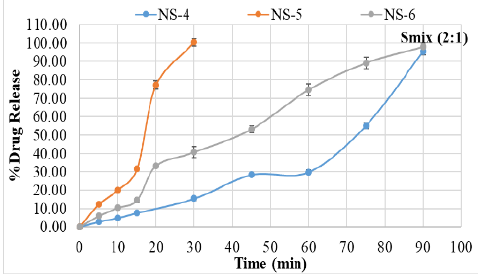
Figure 6. A dissolution profile of LZL NSs (NS-4, NS-5 and NS-6) in 6.8 phosphate buffer pH at 37 °C, all the results represent mean ± SD, where n=3.